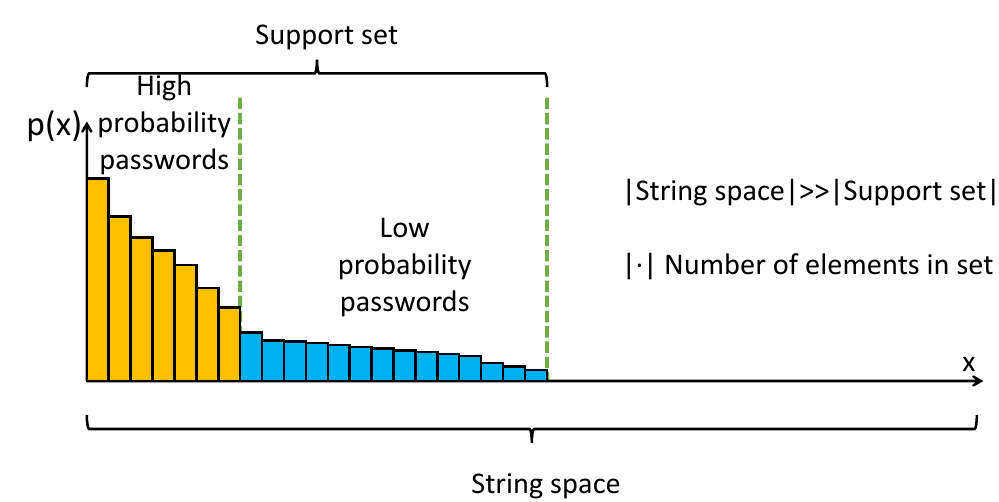
Figure 1. Relationship among string space, support set, and low-probability